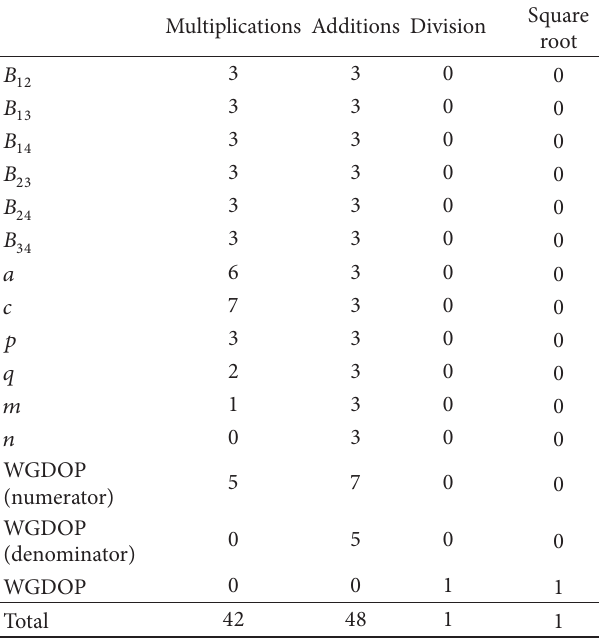
Table 1: The complexity of WGDOP calculation when the four measurements have different error variances.